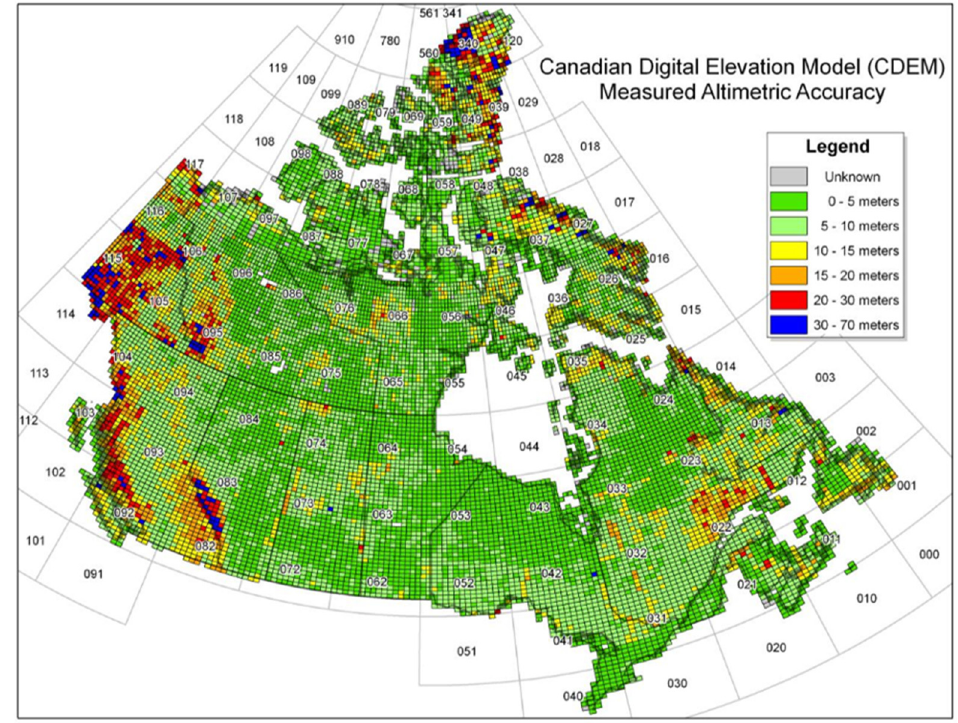
Figure 2. Measured altimetric accuracy per National Topographic System (NTS) map sheet, from [29] .